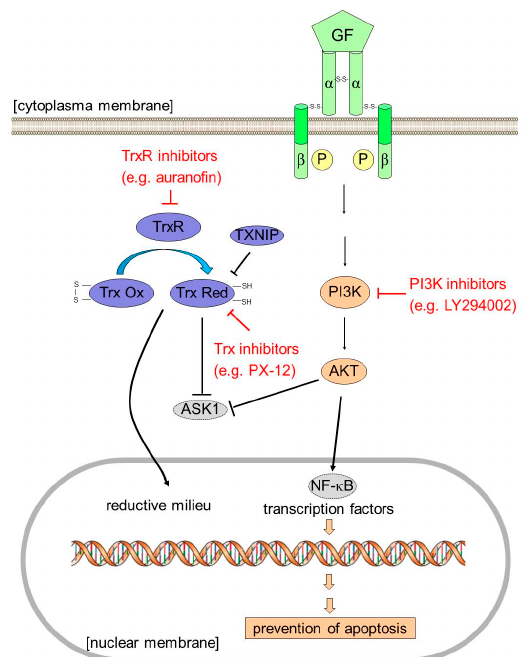
Figure 4. Schematic overview of the Trx system and tentative pathways involved in drug resistance of GBM cells. Potential drug insult to overcome resistance is presented in red. Abbreviations: AKT, protein kinase B (PKB); ASK1, apoptosis signal-regulating kinase 1; GF, growth factor; NF- κ B, nuclear factor kappa-light-chain-enhancer of activated B cells; PI3K, phosphatidylinositide 3-kinase; Trx, thioredoxin; TrxR, Trx-reductase TXNIP, Trx-interacting protein.